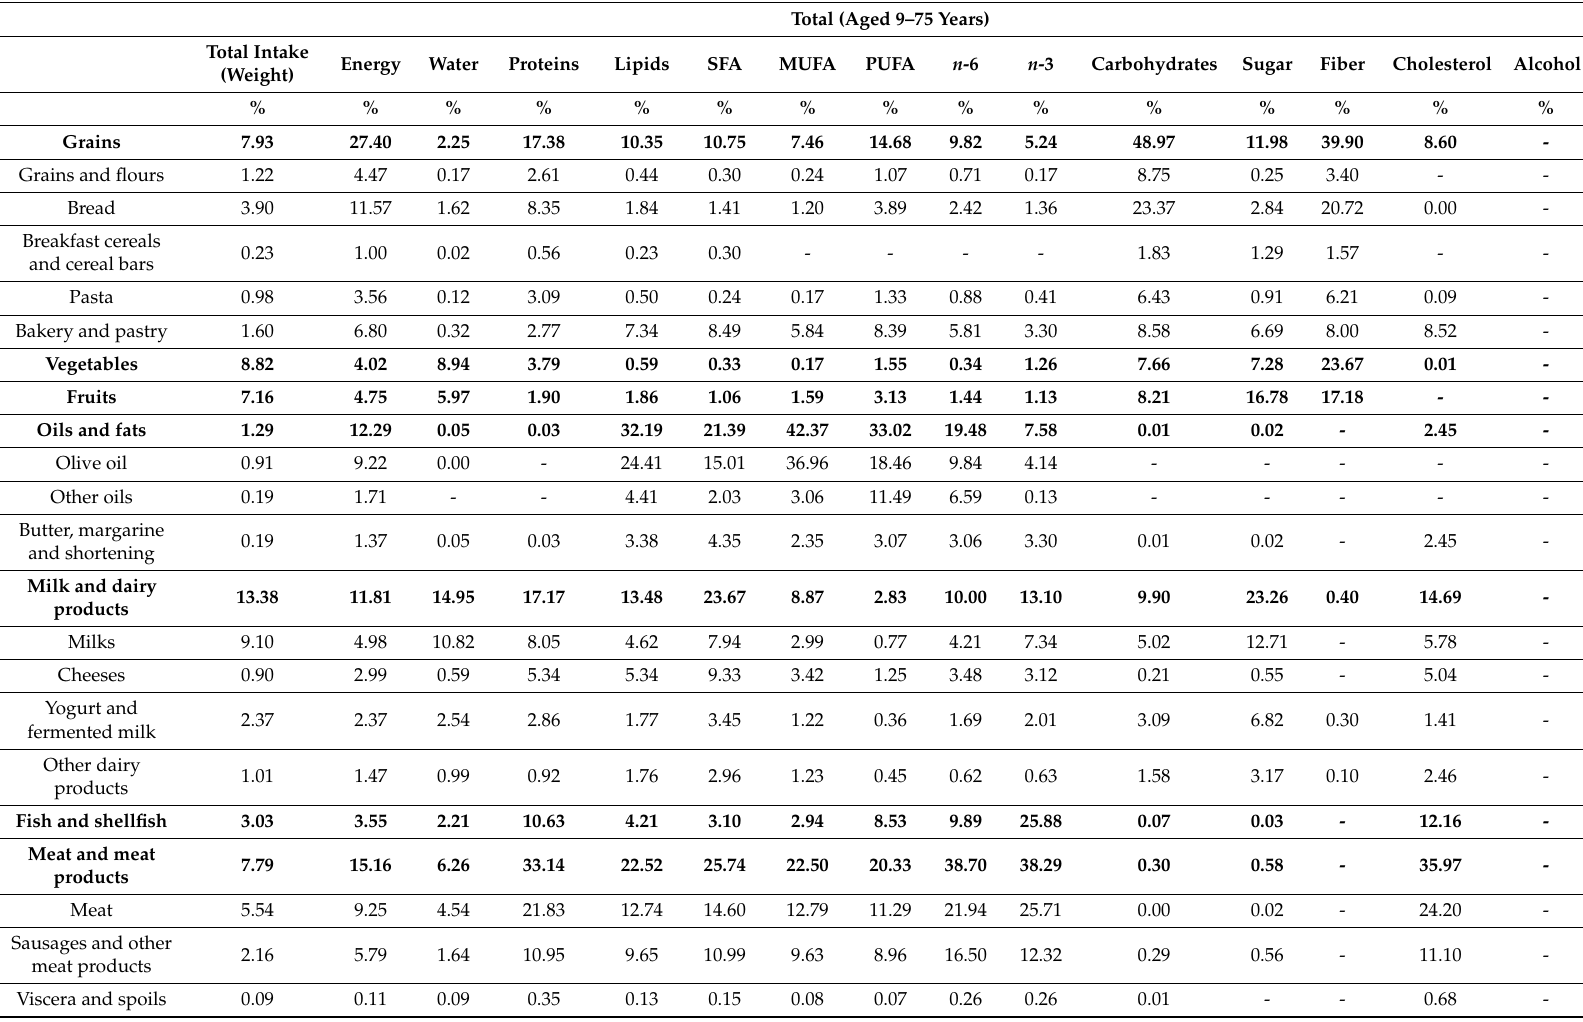
Table 3. Dietary sources of nutrients (%) from food groups/subgroups in the Spanish ANIBES study population aged 9–75 years ( n =